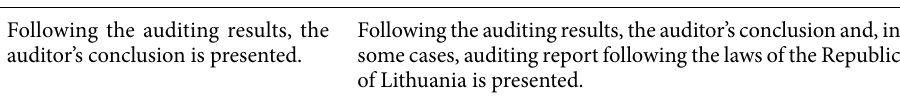
Fig. 1. Comparison of auditor’s functions, duties and